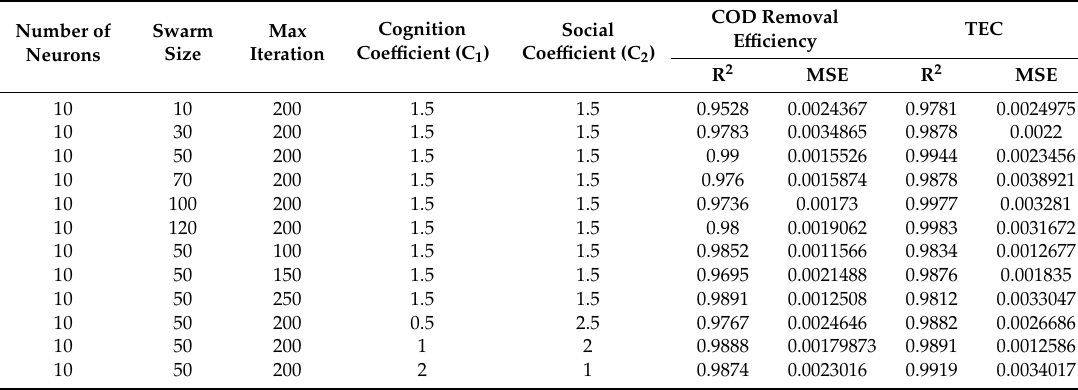
Table 5. PSO–ANN with di ff erent parameters of the PSO